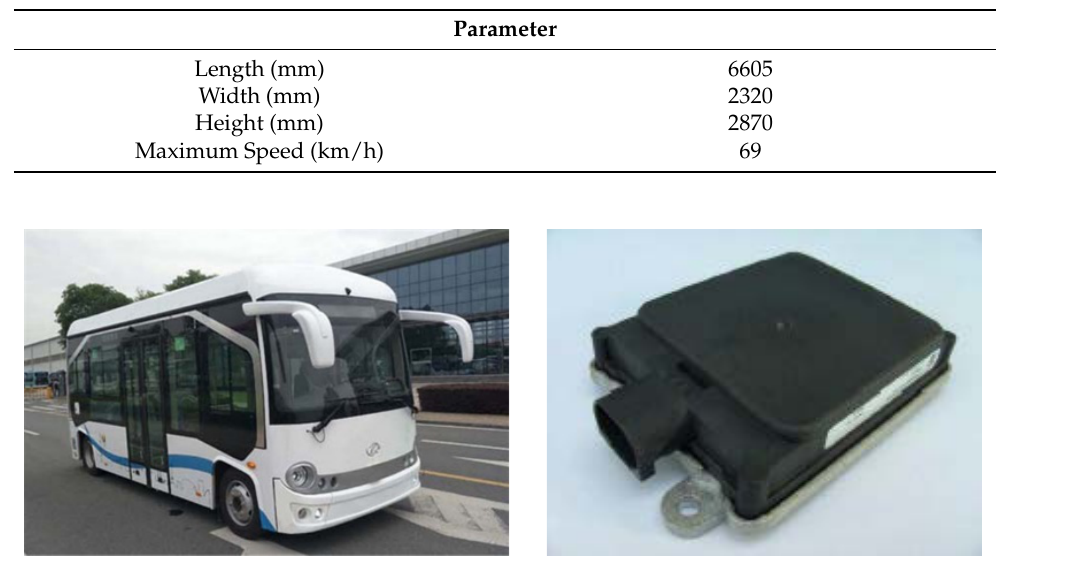
Table 2. Electric bus parameter configuration table.